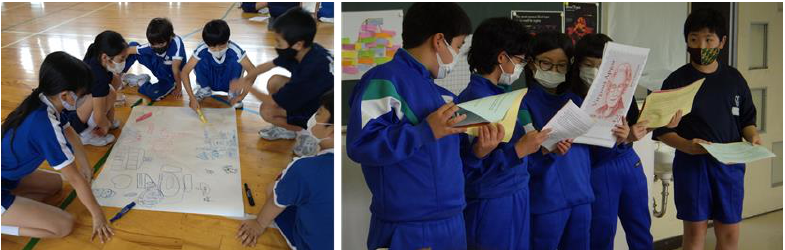
Figure 1. Aims of three Creative Health workshops. Students discuss their favorite foods in the ACT workshop and how to introduce historical figures in medicine during the BODY workshop.